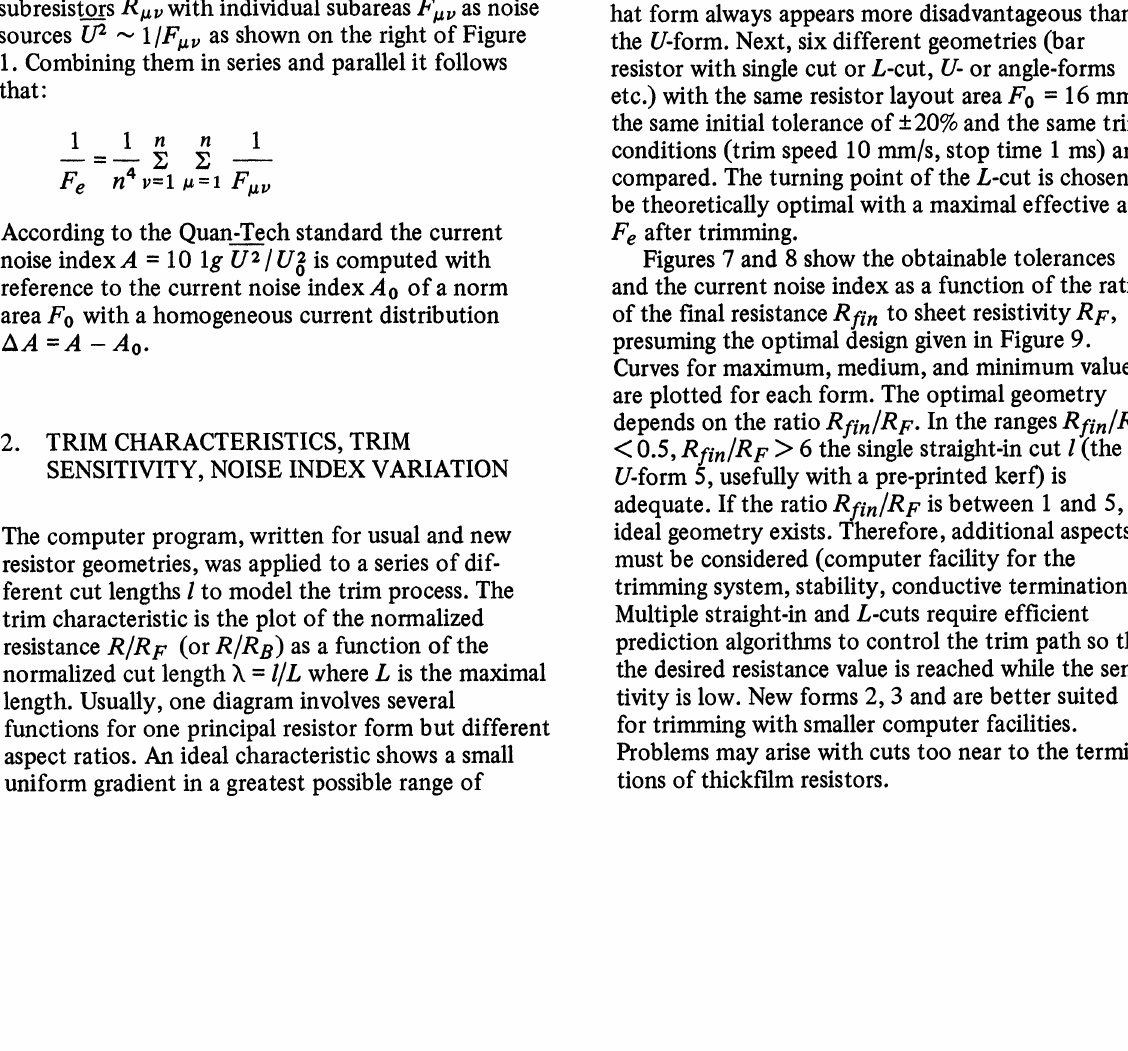
FIGURE 2 Potential and current flow